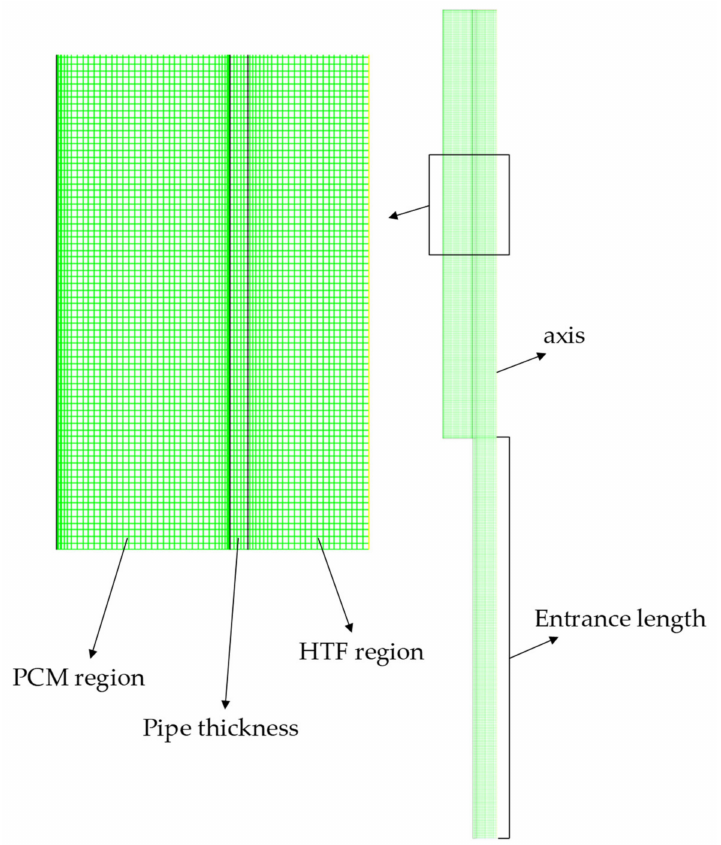
Figure 4. Solution domain and its grid structure.